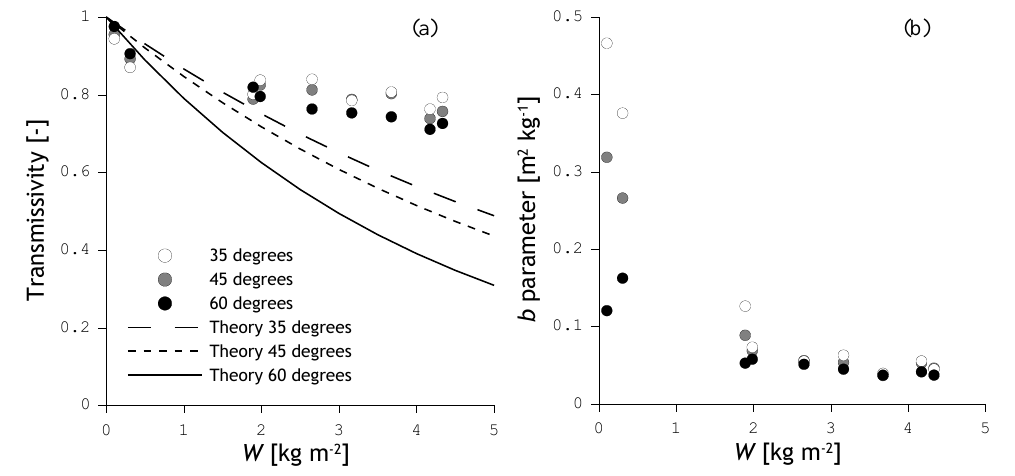
Figure 8. H-polarized corn transmissivities (a) and b parameters (b) inverted from T measured at incidence angles of 35, 45 and 60 degrees plotted against the total plant W .